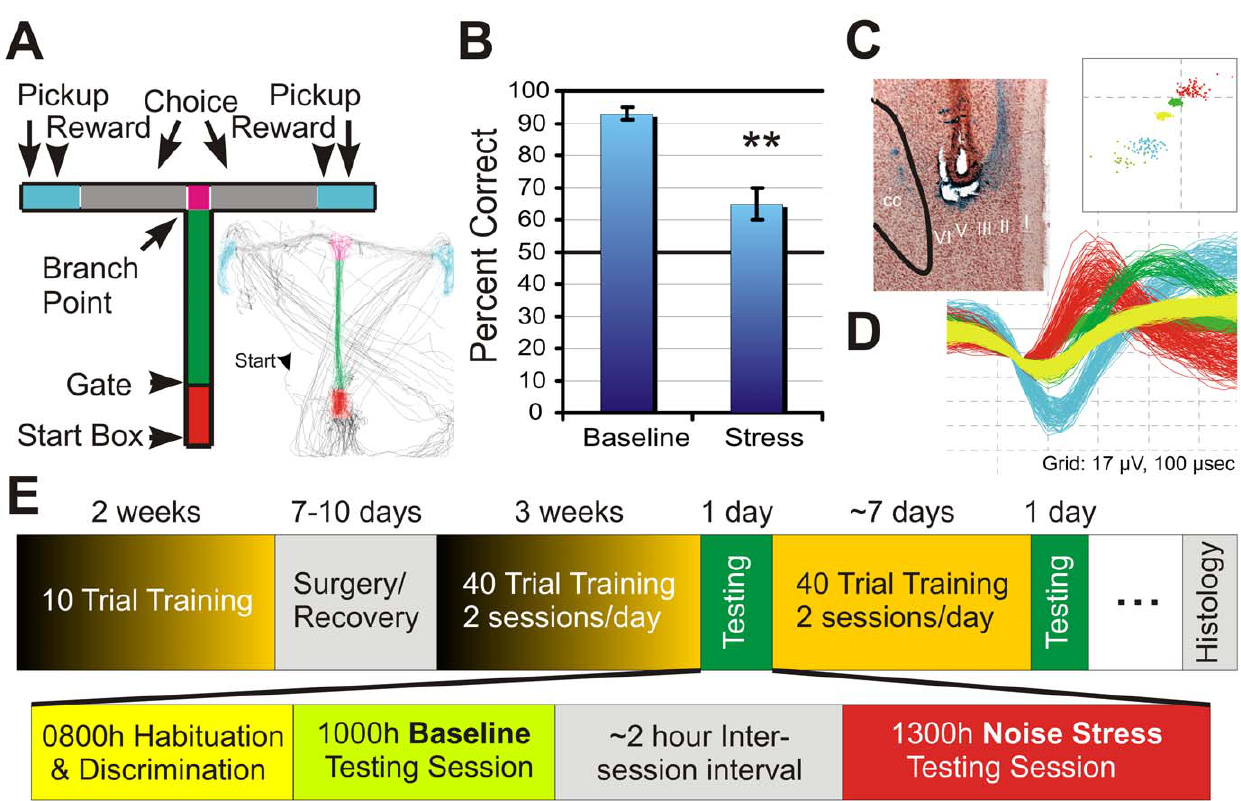
Figure 1. Electrophysiological recordings in rats performing the T-maze Task. A ) Schematic of the T-Maze. On each trial, animals were placed in the start box (red) by the experimenter for a delay interval. The retaining gate was removed and the animal traveled to the branch point and revealed the choice to enter either arm (grey). Reward was then offered by the experimenter within the reward zone (cyan) if the arm opposite to the spatial location of last arm entered was chosen. Following reward or an incorrect choice, the animal was picked up by the experimenter and returned to the start box for a subsequent trial. Inset illustrates the video tracked path of a rat during one recording session. NOTE: paths crossing the T-maze from Pickup to Start Box reflect relocating the animal by the experimenter (right handed). B ) Bar graph quantifying performance in the T- maze task during baseline and acute noise stress (93 db) conditions. n=5; **p , 0.01. C ) 40 6 photomicrograph illustrating the final placement of one of eight microwires in layer V of the pl PFC (Arrow Tip; CC, corpus callosum; pl PFC, prelimbic PFC). D ) Action potential waveforms of 5 discriminated and validated pl PFC neurons. Waveform width=450 m s. Waveforms from these units exhibited separable clusters when plotted in principal component space (inset). Sorted spiking activity with unsorted activity is presented in Fig. S1. The cyan colored neuron represents the characteristic WS-type neuron. E ) Timeline of behavioral training and testing. Details of a single testing day are shown beginning at 8:00 AM.